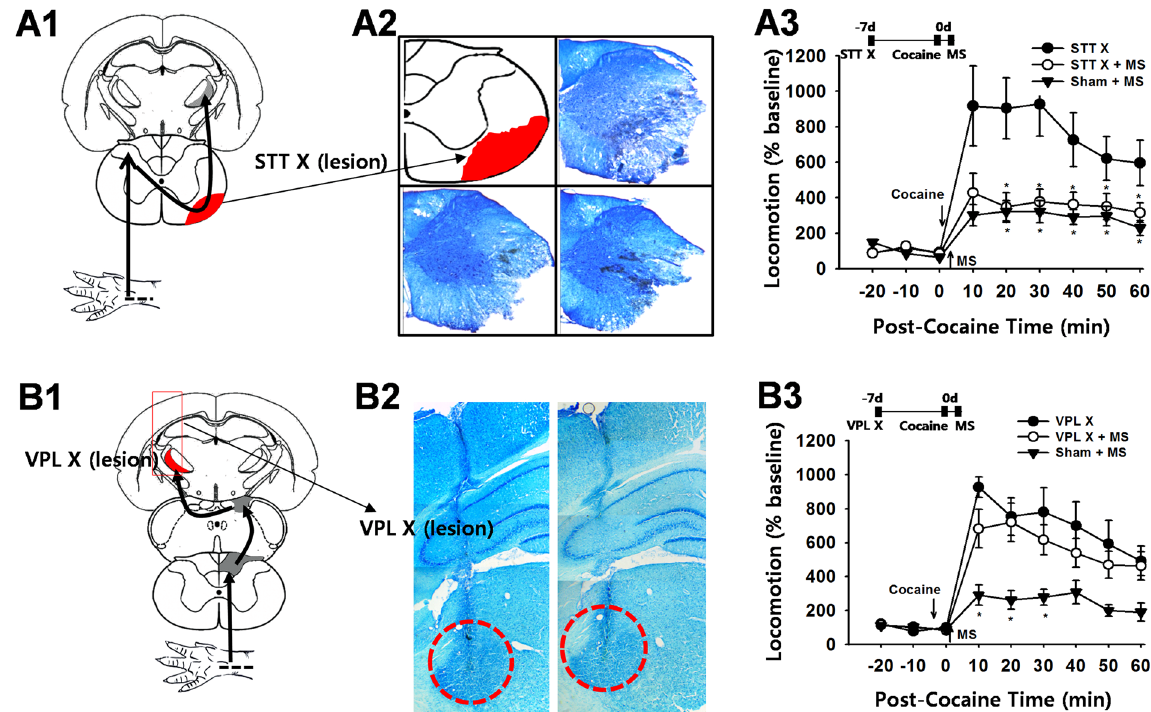
Figure 3. The effects of STT or VPL lesions on the ulnar inhibition of cocaine locomotion. ( A ) STT lesions (STT X) at the C3 level of the spinal cord (A1–2) did not affect ulnar MS-induced inhibition of cocaine-induced locomotion (STT X + MS; n = 8) when compared to the control group (STT X; n = 7) or ulnar stimulation without STT lesion (Sham + MS; n = 6; A3). * p < 0.05 vs. STT X. Representative images of STT lesions stained by toluidine blue (A2). ( B ) Bilateral chemical lesions of the VPL (B1–2) block the inhibitory effects of cocaine locomotion by ulnar MS (VPL X + MS; n = 7), compared to the control groups of VPL X ( n = 7) and Sham + MS ( n = 6; B3). * p < 0.05 vs. Sham + MS or VPL X +